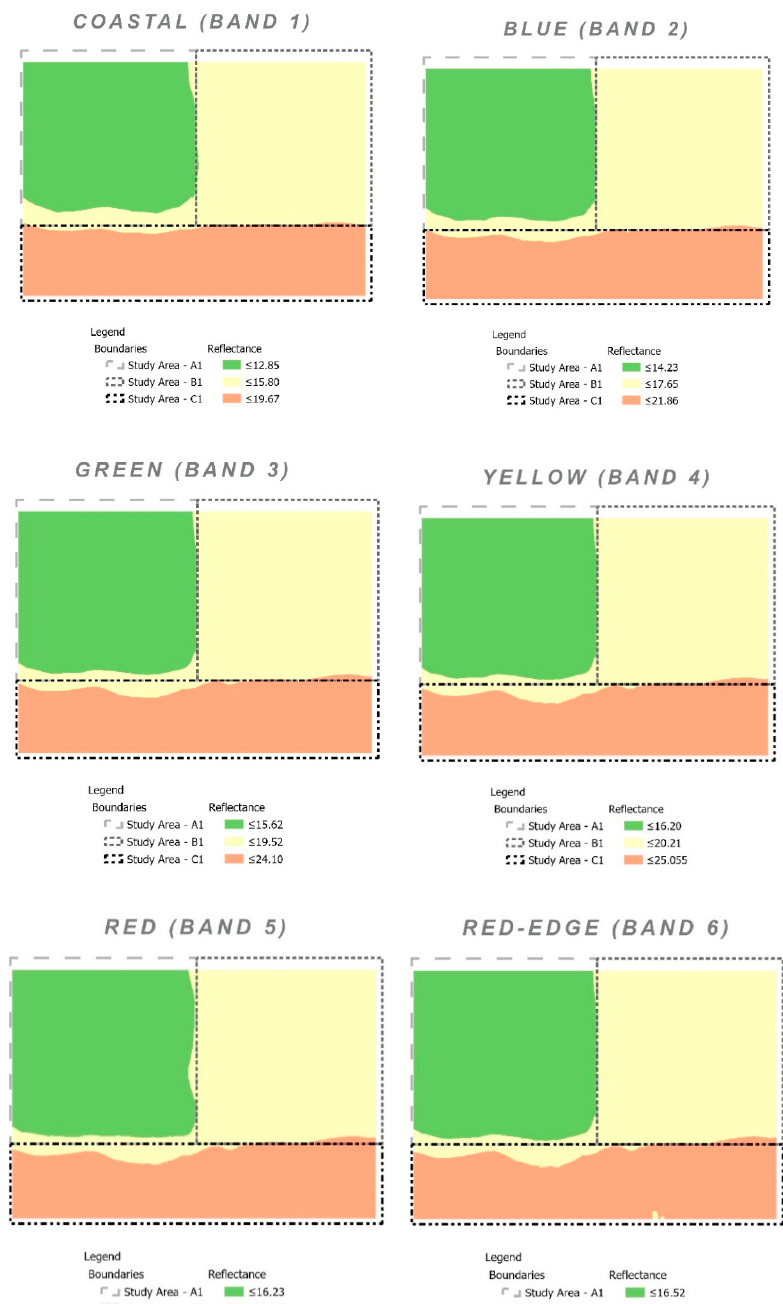
Figure 10. Classification of the three asphalt pavement age categories by using the reflectance values in each WV3 band examined.